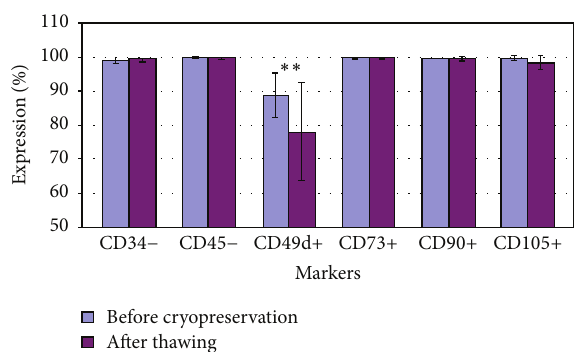
Figure 1: Surface markers expression of cells before cryopreserva- tion and after thawing. The analysis was done by Cyflogic software 1.2.1. The 𝑡 -test was done; 𝑝 < 0.05 was considered significant. The results were 𝑝 ∗∗ = 0, 001